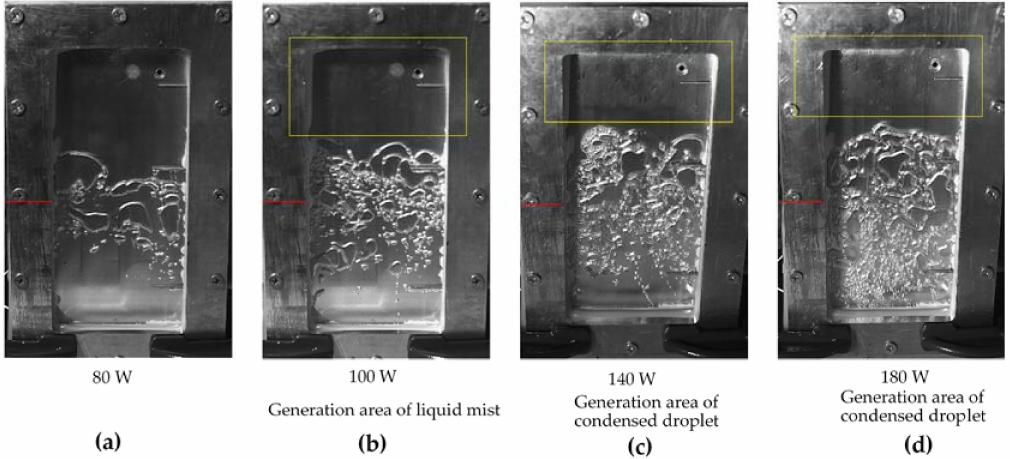
Figure 20. The images of gas-liquid two-phase behavior in the cavity of PGHP under different heating power inputs (FR = 48%). Note: the initial level is shown as the red line, ( a ) condensation behavior at 80 W; ( b ) 100 W; ( c ) 140 W; ( d ) 180